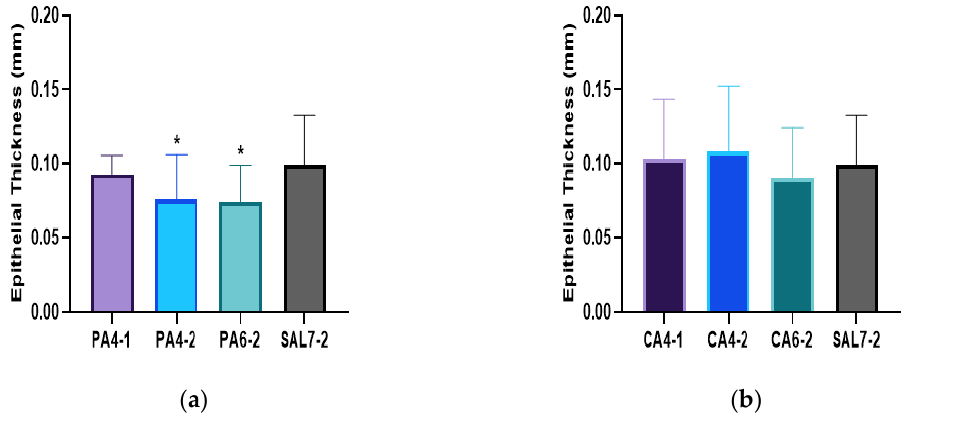
Figure 3. Comparison of epithelial thickness as an indication of the quality of regenerated wound between ( a ) phosphoric acid (PA) buffered solution treatment groups on day 7 and ( b ) citric acid (CA) buffered solution treatment groups on day 7 post-wounding with saline control group (SAL7-2). Each bar represents mean ± standard deviation. * p <0.05 indicates the results obtained were statistically significant from control group (SAL7-2). PA4-1 n = 14/14, PA4-2 n = 15/16, PA6-2 n = 13/16, CA4-1 n = 16/16, CA4-2 n = 15/16, CA6-2 n = 12/14 and SAL7-2 n = 8/12. Histological analysis of wound-contraction by measurement of the gap between the striated panniculus carnosus muscle was also assessed to understand the effect of acidic buffer solutions on wound contraction. The rate of wound contraction was significantly faster for PA4-2 ( p -value = 0.0003), CA4-1 ( p -value = 0.0201), CA4-2 ( p -value = 0.0079) and CA6-2 ( p -value = 0.0419) in comparison to control saline group. Panniculus gap measurement of phosphoric acid (PA) treated wound tissues was measured at 3.39 ± 0.55 mm (PA4-1), 2.79 ± 0.88 mm (PA4-2) and 3.27 ± 0.58 mm (PA6-2), respectively. Citric acid (CA) treatment groups were measured at 3.14 ± 0.54 mm for CA4-1, 3.06 ± 0.66 mm for CA4-2 and 3.19 ± 0.86 mm for CA6-2. Panniculus gap measurement of control saline group (SAL7-2) treatment showed the widest gap in comparison to all other acidic treatment groups measured at 3.81 ± 0.61 mm (Figure 4).